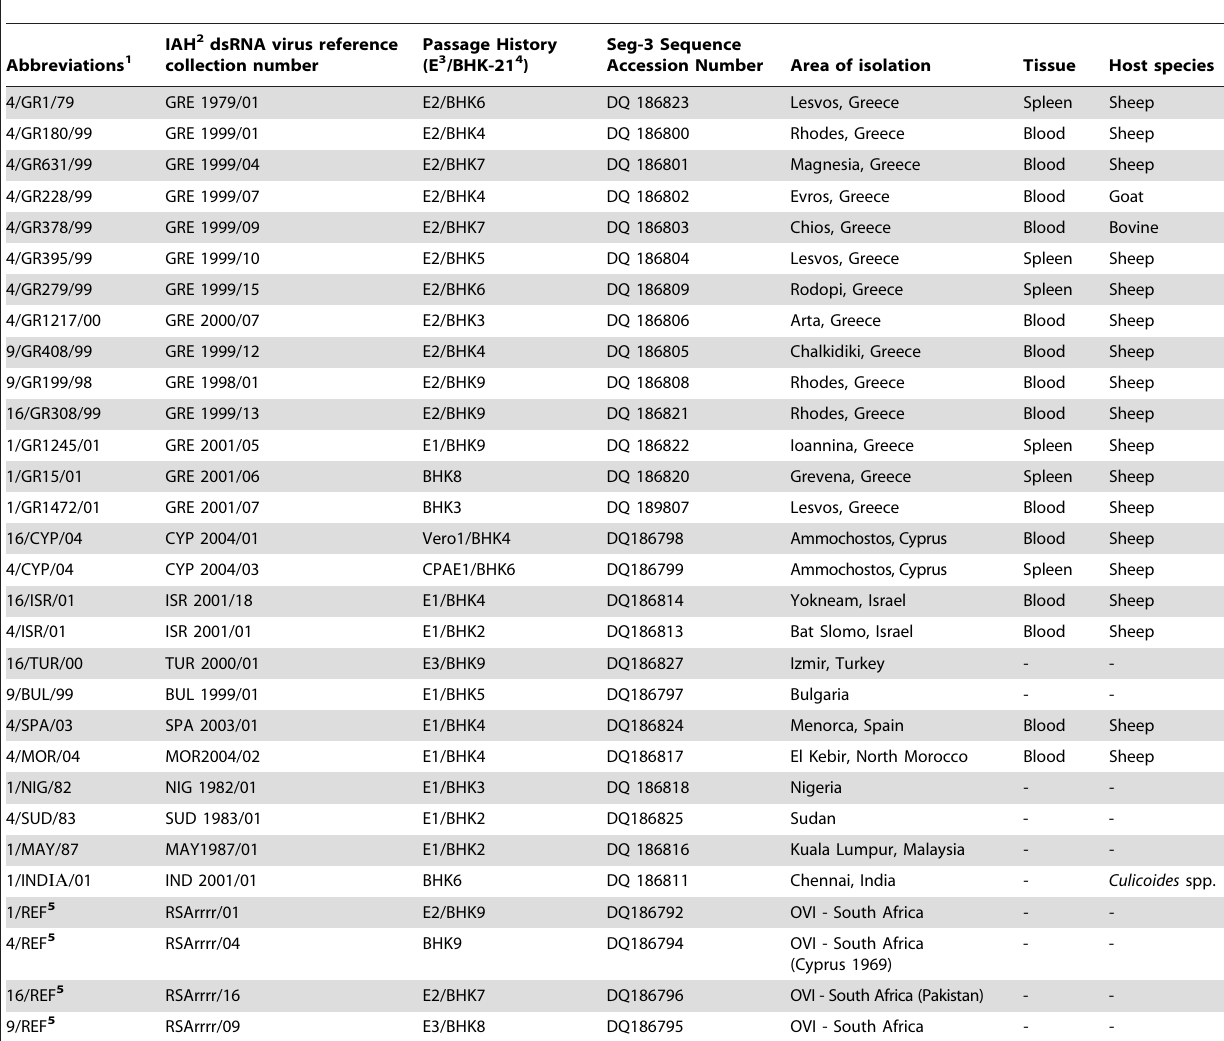
Table 1. BTV field isolates sequenced in this study. Further details of the isolates can be obtained from the dsRNA virus reference collection